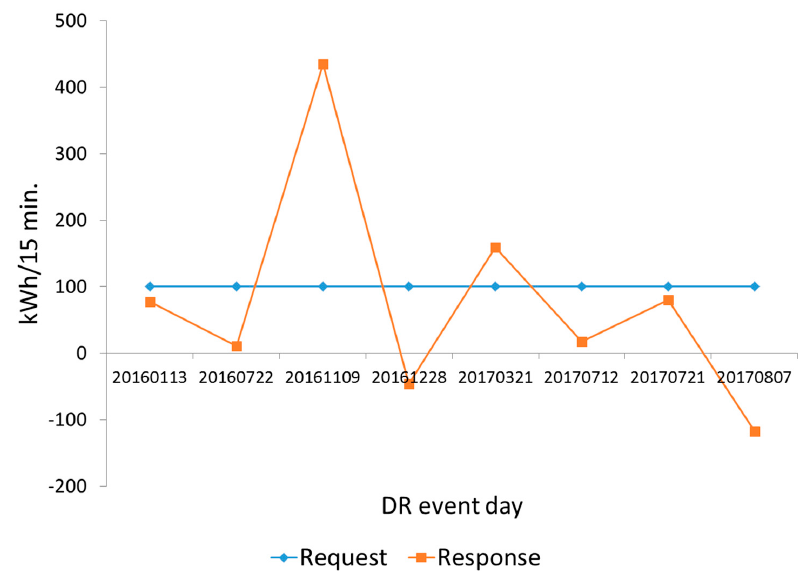
Figure 2. Uncertainty of load curtailment.